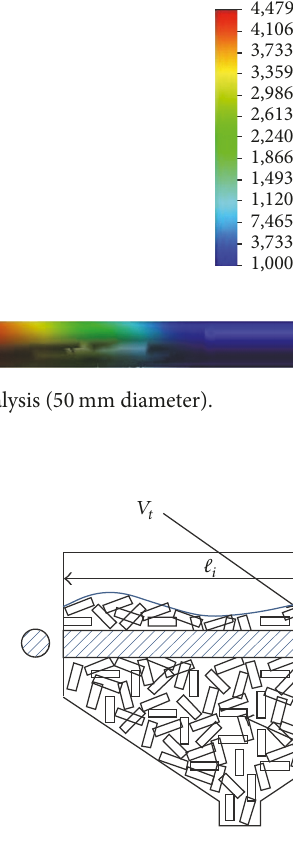
Figure 9: Structural diagram of reactor showing total piled volume and shaft